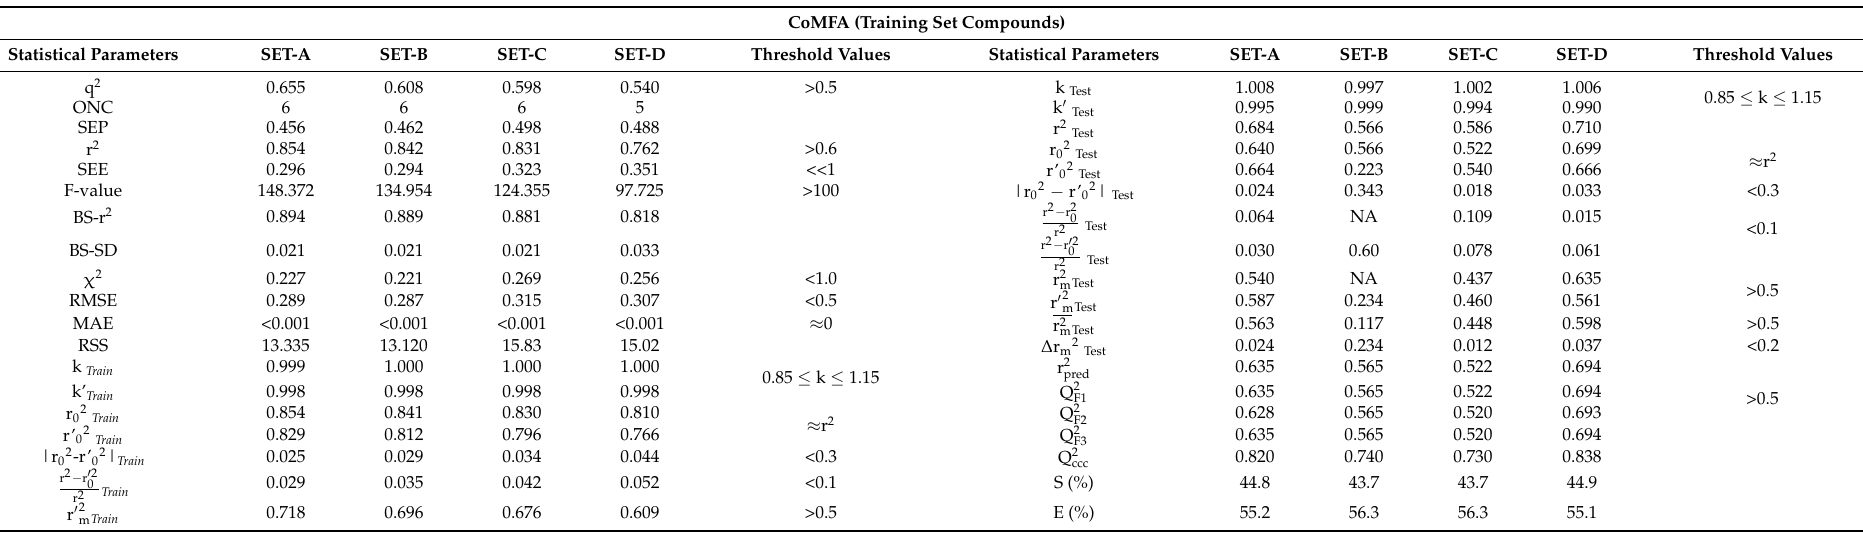
Table 7. Statistics of the CoMFA models of training set compounds of PI3K γ